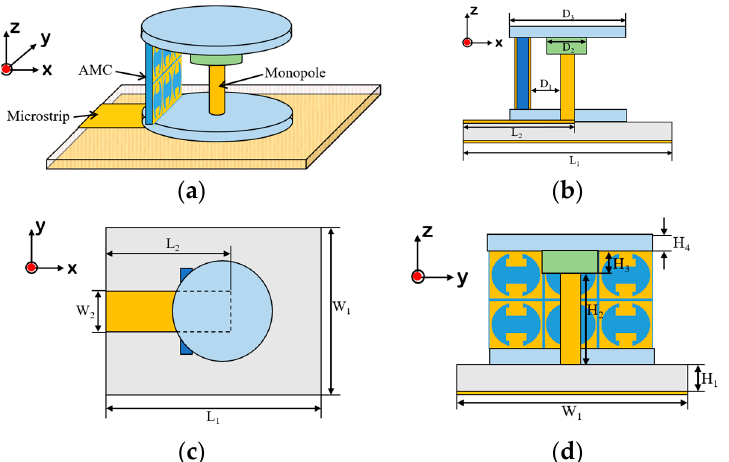
Figure 1. The configuration and details: ( a ) the whole configuration, ( b ) the side view of zox -plane, ( c ) the top view of xoy -plane, and ( d ) the side view of yoz -plane.